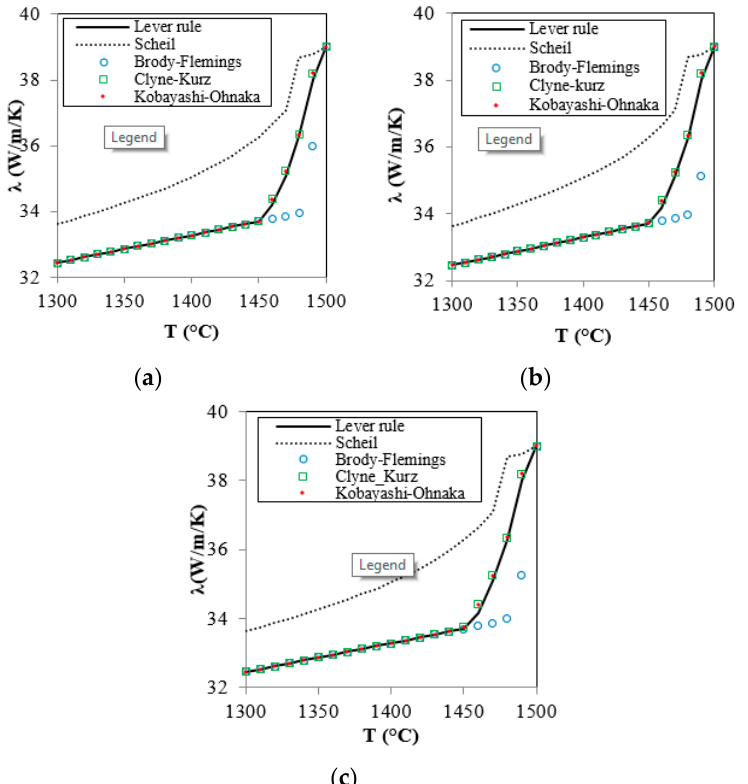
Figure 5. Temperature dependence of thermal conductivity for the steel in study according to different microsegregation solidification models for the case ( a ) α = 10.57(ingot wall side); ( b ) α = 12.60 (mid-radius region); ( c ) α = 12.66 (ingot center).